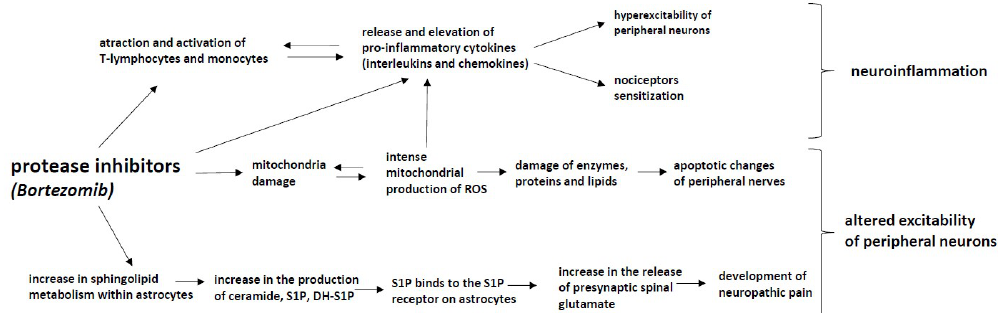
Figure 6. The mechanisms of CIPN induced by protease inhibitors: Protease inhibitors increase the metabolism of sphingolipids in astrocytes, which leads to the formation of ceramide, sphingosine-1 phosphate (S1P) and dihydrosphingosine-1-phosphate (DH-S1P), which by binding to astrocyte receptors, increase the release of presynaptic glutamate at the level of the dorsal horn, which leads to the development of neuropathic pain. Moreover, bortezomib-induced mitochondrial damage increases the production of reactive oxygen species (ROS), which results in enzyme, protein and lipid damage within the neurons as well as induces apoptotic changes in peripheral nerves. These processes alter the excitability of peripheral neurons, whereas the attraction and activation of T-lymphocytes and monocytes, as well as the increases in the production of reactive oxygen species (ROS) induce the release and elevation of pro-inflammatory cytokines (interleukins and chemokines). These processes lead to nociceptor sensitization, the hyperexcitability of peripheral neurons and the development of neuroinflammation.